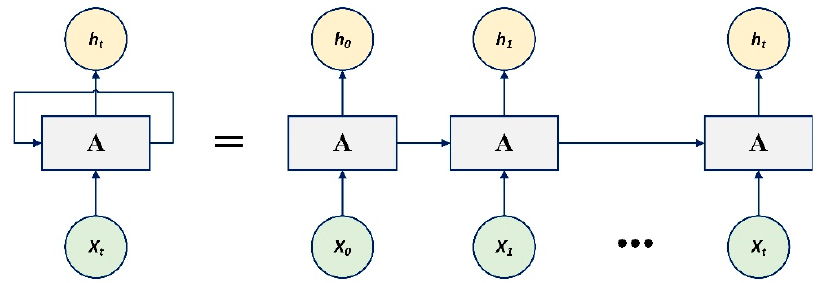
Figure 3. Graphical illustration of RNN structures.